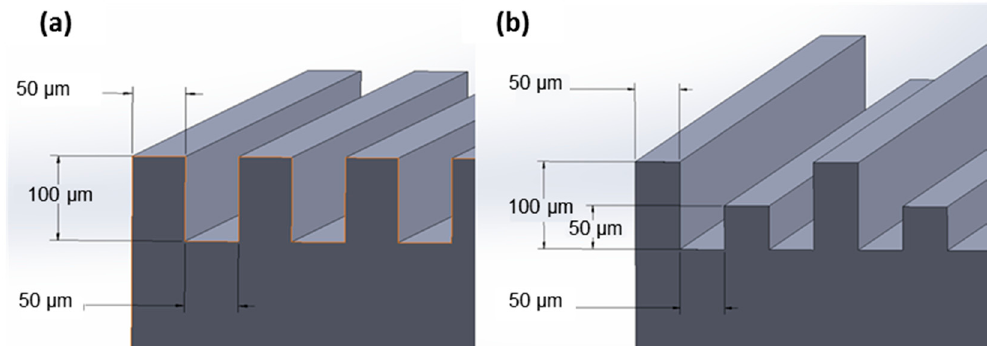
Figure 1. Desired designs of ( a ) the channeled structure and ( b ) the varied channeled structure.